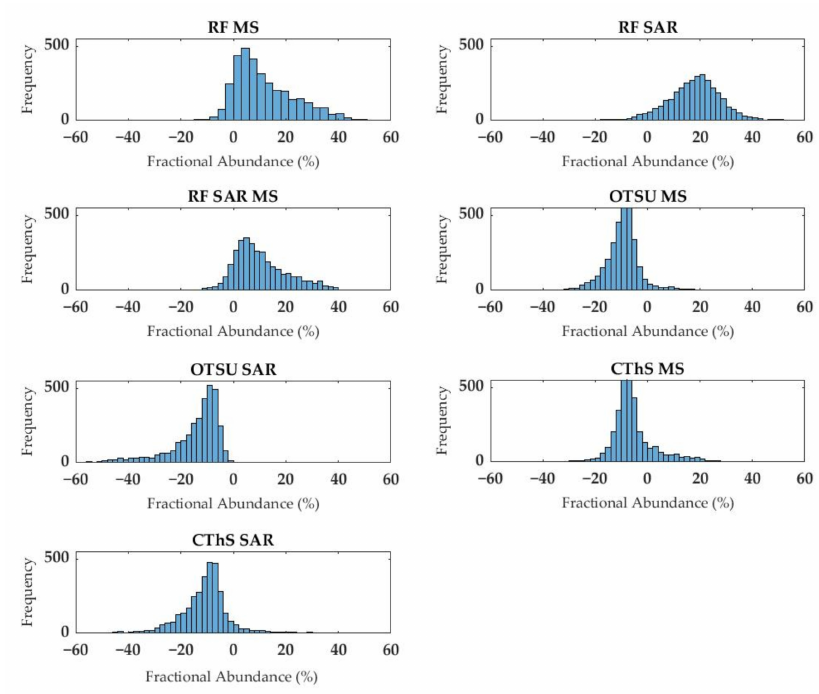
Figure 13. Deviation from the median value of the fractional abundance of water (event 2020) calculated over the nodes of a regular 500 m